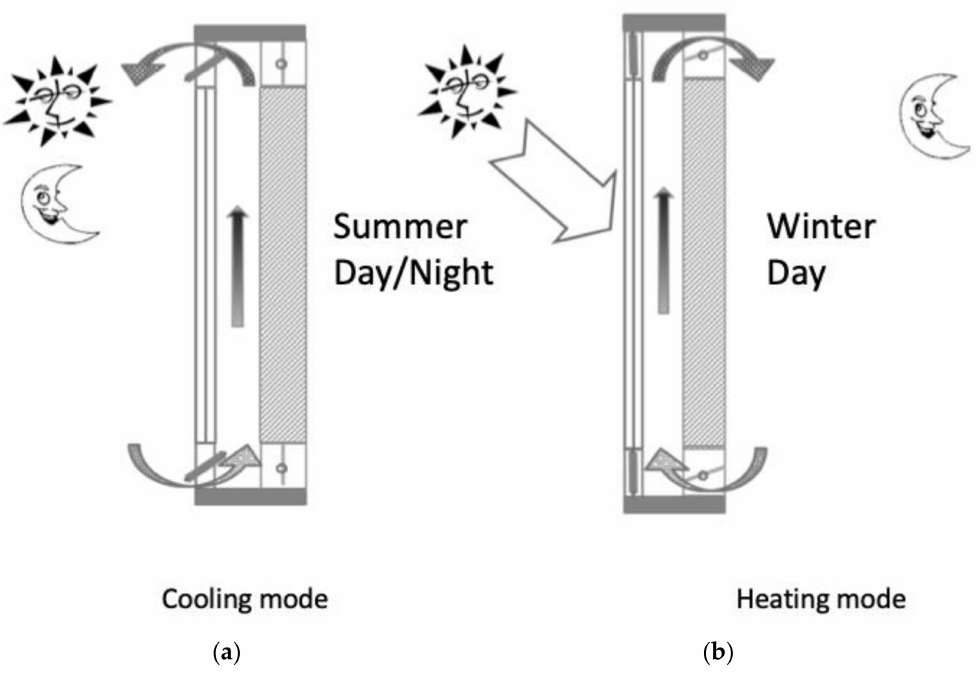
Figure 1. Manual operation work of a BIPVT system: ( a ) cooling mode; and ( b ) heating mode